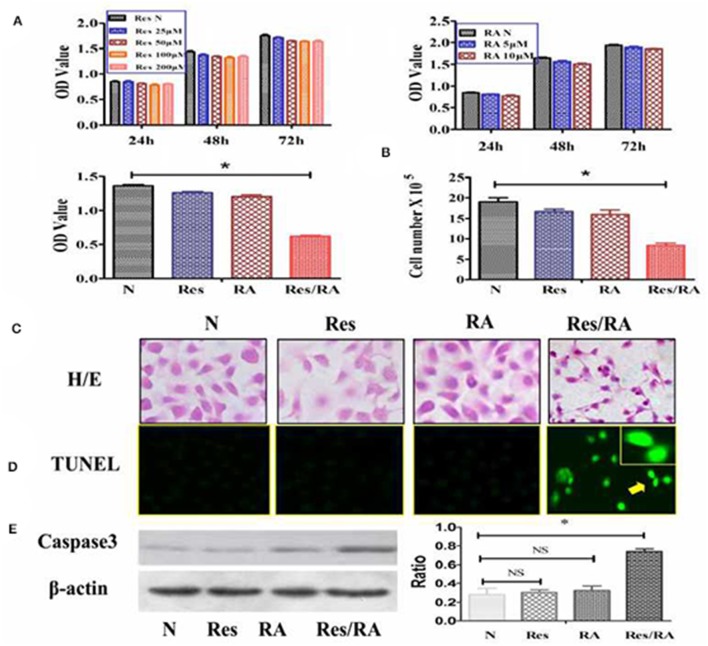
Resveratrol improved RA sensitivity of anaplastic thyroid cancer THJ-11T cells. (A) 3-[4,5-Dimethylthiazol-2-yl]-2,5-diphenyl-tetrazolium bromide (MTT) cell proliferation assay; (B) viable cell counting after drug treatment for 48 h; (C) H&E morphological staining(×40); (D) deoxynucleotidyl transferase-mediated dUTP-biotin nick and labeling assay (TUNEL) for apoptotic cell labeling (Green in color; ×40); (E) Western Blotting; N, cultured in 0.2% dimethylsulfoxide (DMSO)-containing medium; Res, 100 μM resveratrol treatment; RA, 10 μM retinoic acid treatment; Res/RA, treated with a combination of 100 μM resveratrol and 10 μM retinoic acid for 48 h. Ratio, the ratio between the levels of the target molecules and that of β-actin; NS, no statistical significance (p > 0.05); *p < 0.01; the error bars, the mean ± standard deviation. Arrows indicate the region with higher magnification (×80) in the insets.